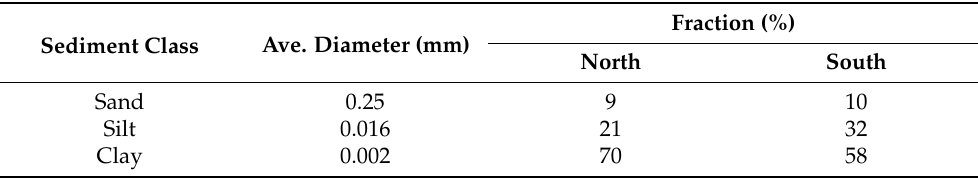
Table 3. Fraction and Average Diameter of Eroded Soil Particles from the North and South Sides of the Wilson Creek Construction Site Developed by the OEM for the Without-construction Scenario.